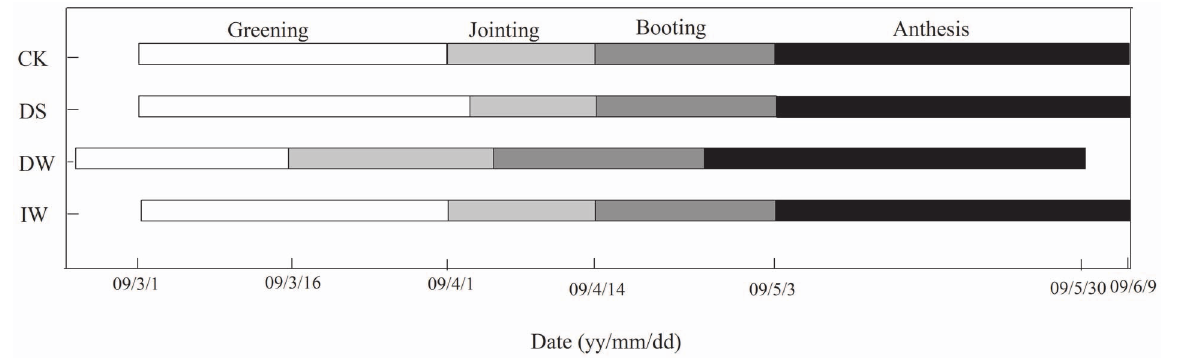
Figure 4. Growth stages of four treatments, i.e. control (CK), delay sowing date as well as warming (DS), warming both day and night (DW), increase water addition as well as warming (IW).